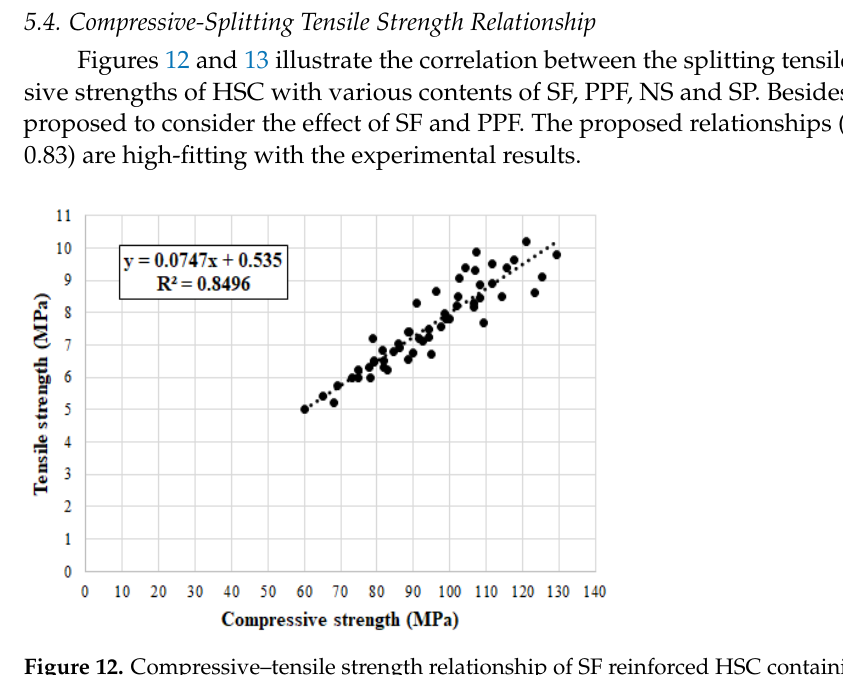
Figure 13. Compressive – tensile strength relationship of PPF reinforced HSC containing NS and SP. 5.5. Modulus of Elasticity The initial and secant moduli of elasticity of all concrete mixes are presented in Fig- ures 14 and 15, where the influence of NS, SP, PPF and SP is illustrated. ( a ) ( b ) Figure 14. Effect of fibre on the initial modulus of elasticity of HSC containing NS and SP ( a ) SF and ( b ) PPF.